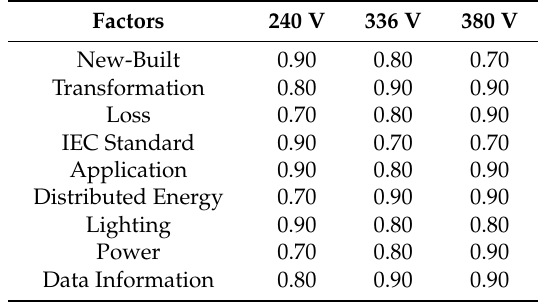
Table 2. Quantitative fuzzy comprehensive evaluation of the three low voltage levels.